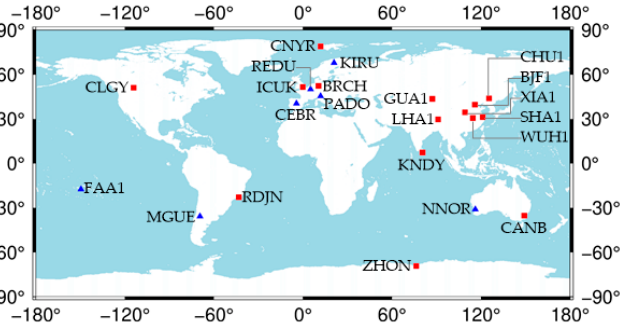
Figure 2. Distribution of the 22 MGEX (blue triangle) and iGMAS (red square) stations from which the data was used in this study. Table 2. Detailed information of the 22 GNSS tracking stations.